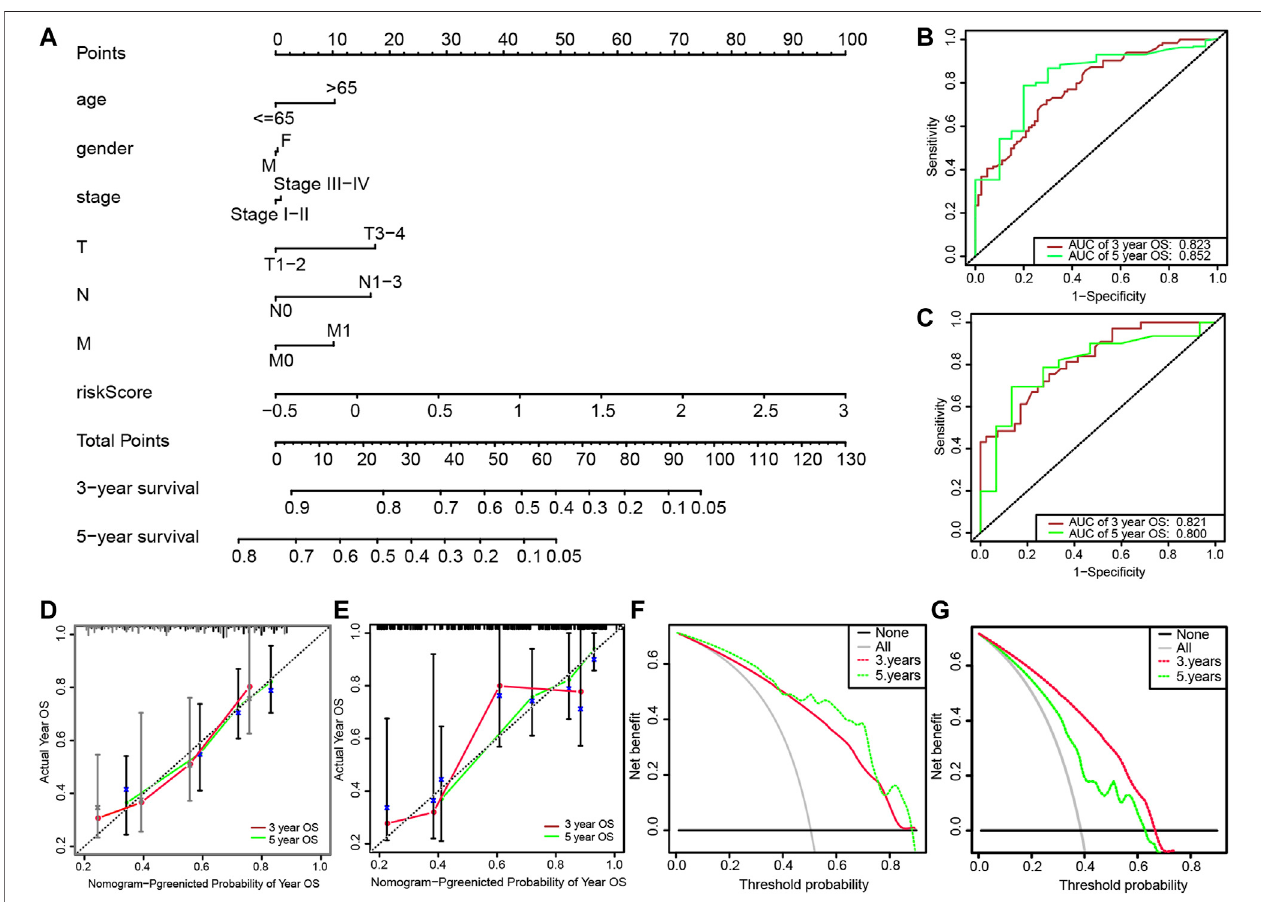
FIGURE 5 | ( A ) Nomogram for predicting 3-years and 5-years survival rates of patients with lung adenocarcinoma; ( B ) ROC curve analysis for predicting 3-years and 5-years OS through nomogram in the training set; ( C ) ROC curve analysis for predicting 3-years and 5-years OS through the nomogram in the validation set; ( D ) Calibrationof3-yearssurvivalratebasedonthenomogram;( E )Calibrationof5-yearssurvivalratebasedonthenomogram;( F )Decisioncurveanalysisof3-yearssurvival rate based on the nomogram; ( G ) Decision curve analysis of 5-years survival rate based on the